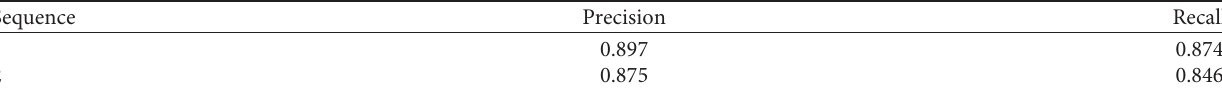
Figure 10: Instant velocity estimation of each cell in x and y coordinates. Table 3: Performance measures of our method on two